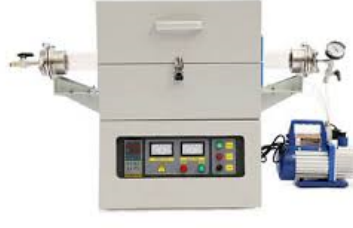
Figure 3: Vacuum sintering tube